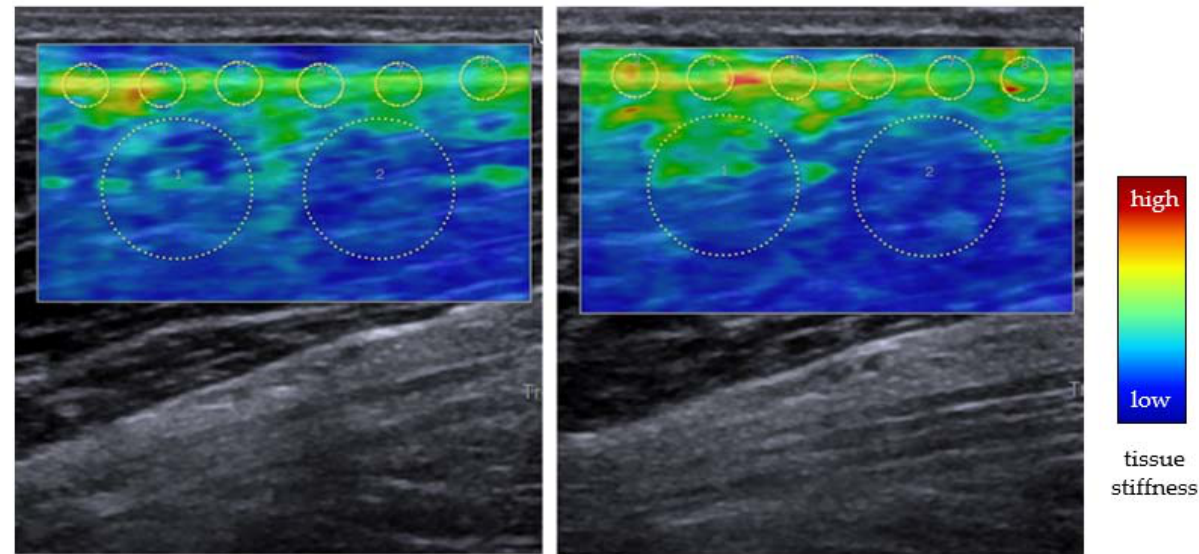
Figure 2. Shear-wave elastography (SWE) of the ventral thigh before ( left ) and 48 h ( right ) after lower leg eccentric exercise. In SWE, an acoustic radiation force impulse is used to produce shear waves traveling perpendicularly. Measuring the speed of this horizontal shear wave propagation allows the calculation of mechanical properties. The colored regions of interest indicate the tissue’s mechanical stiffness: while blue represents low values, red represents high values. Note the marked stiffness increase in and near the deep fascia over the muscle (small circles). The scans used for this figure were acquired in the authors’ laboratory.